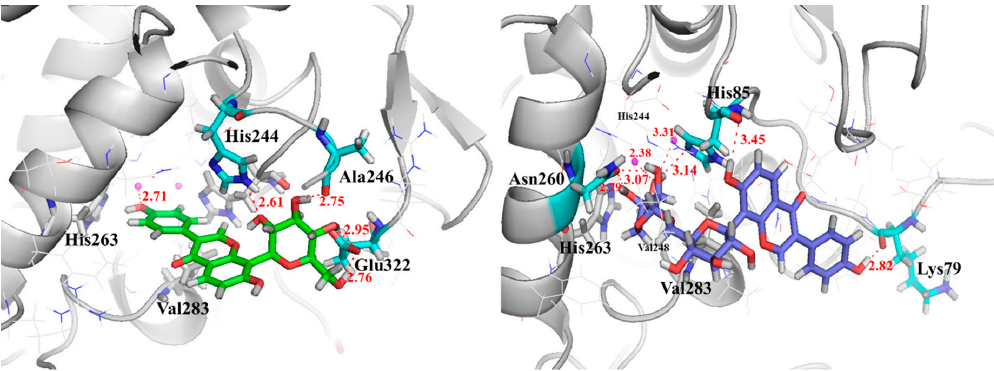
Figure 4. The conformations of puerarin ( left ) and mirificin ( right ) binding to the active site of